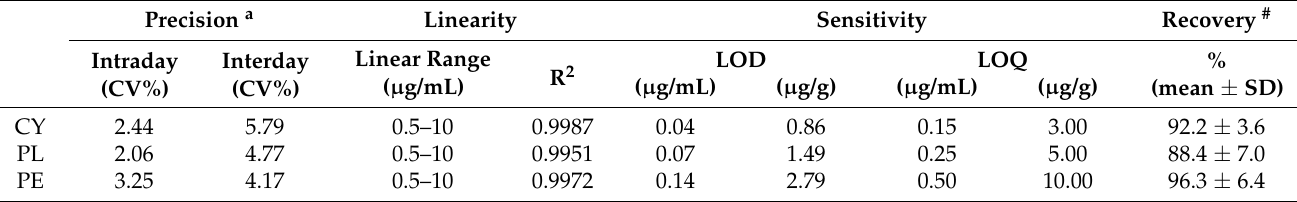
Table 3. HPLC-DAD validation parameters for the analysis of